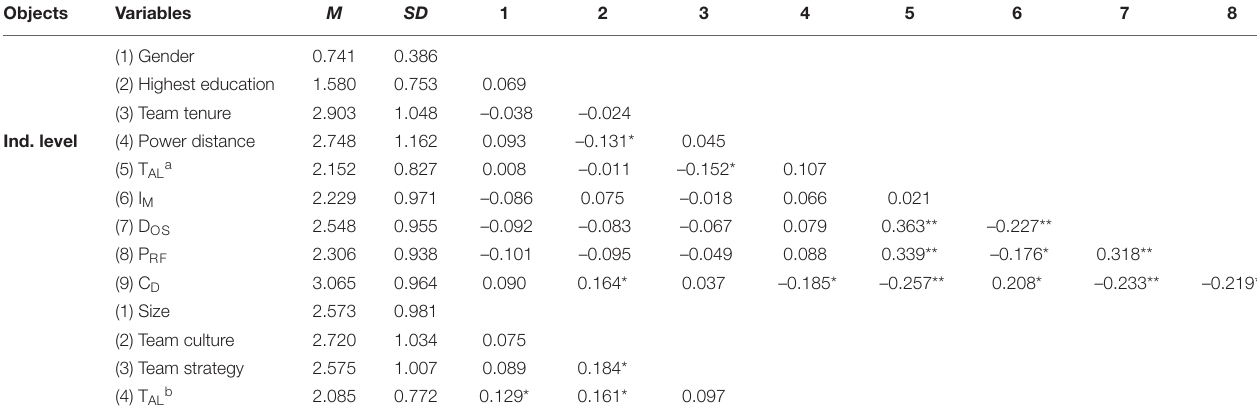
TABLE 4 | Descriptive statistics and